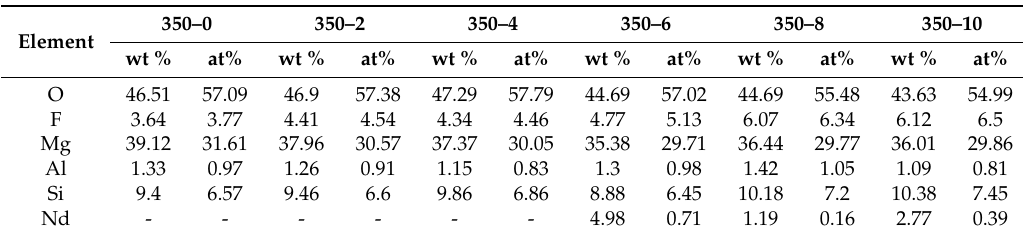
Figure 4. The test result of Energy dispersive X-ray spectrometer (EDS): ( a ) 350–0, ( b ) 350–2, ( c ) 350–4, ( d ) 350–6, ( e ) 350–8, and ( f ) 350–10. Table 2. The EDS result of MAO coatings.